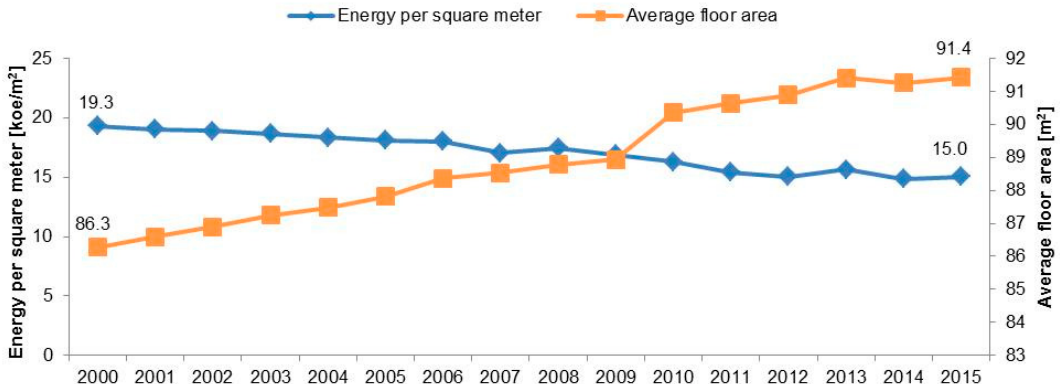
Figure 12. Average final energy per unit of area and average floor area in the EU-28, 2000–2015. Source: